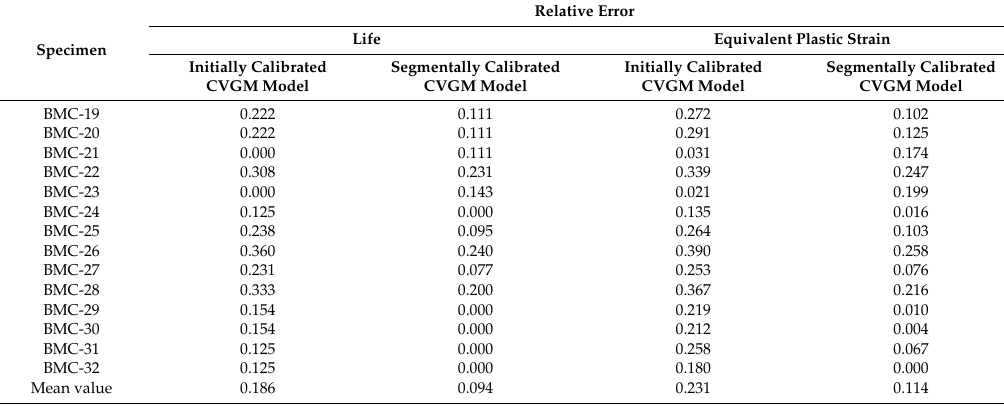
Figure 13. Comparisons of experimental and FEA results: ( a ) Number of cycles to fracture; ( b ) Figure13. ComparisonsofexperimentalandFEAresults: ( a )Numberofcyclestofracture; ( b )Equivalent Equivalent plastic strain up to fracture. plastic strain up to fracture. Table 6. Relative error of prediction results by CVGM Table 6. Relative error of prediction results by CVGM model.